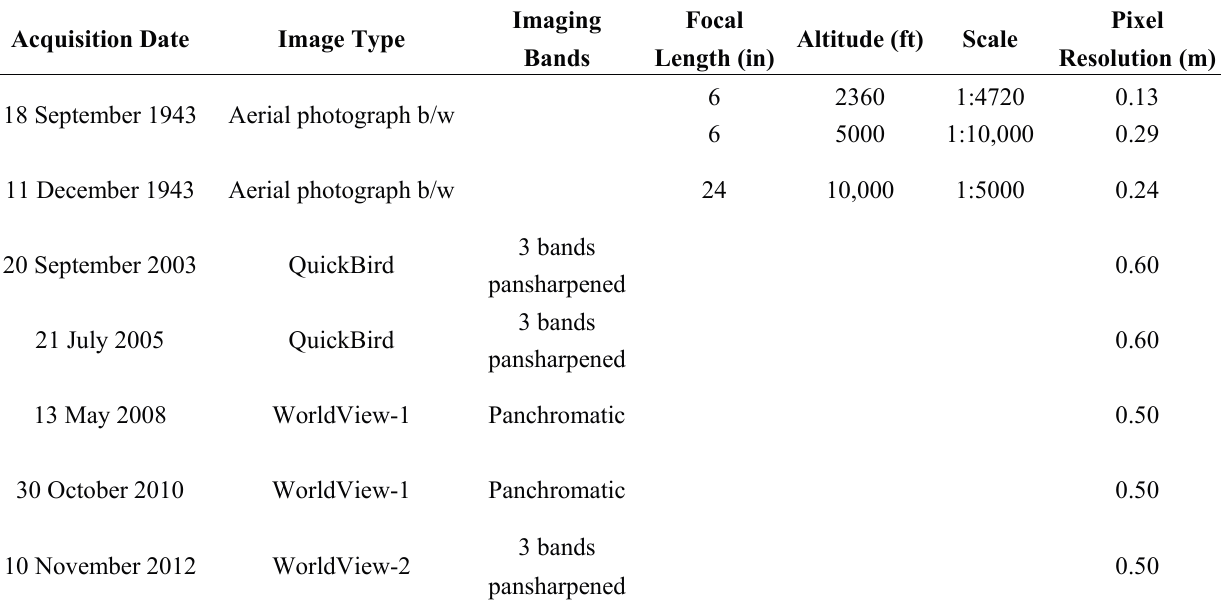
Table 2. Summary of image